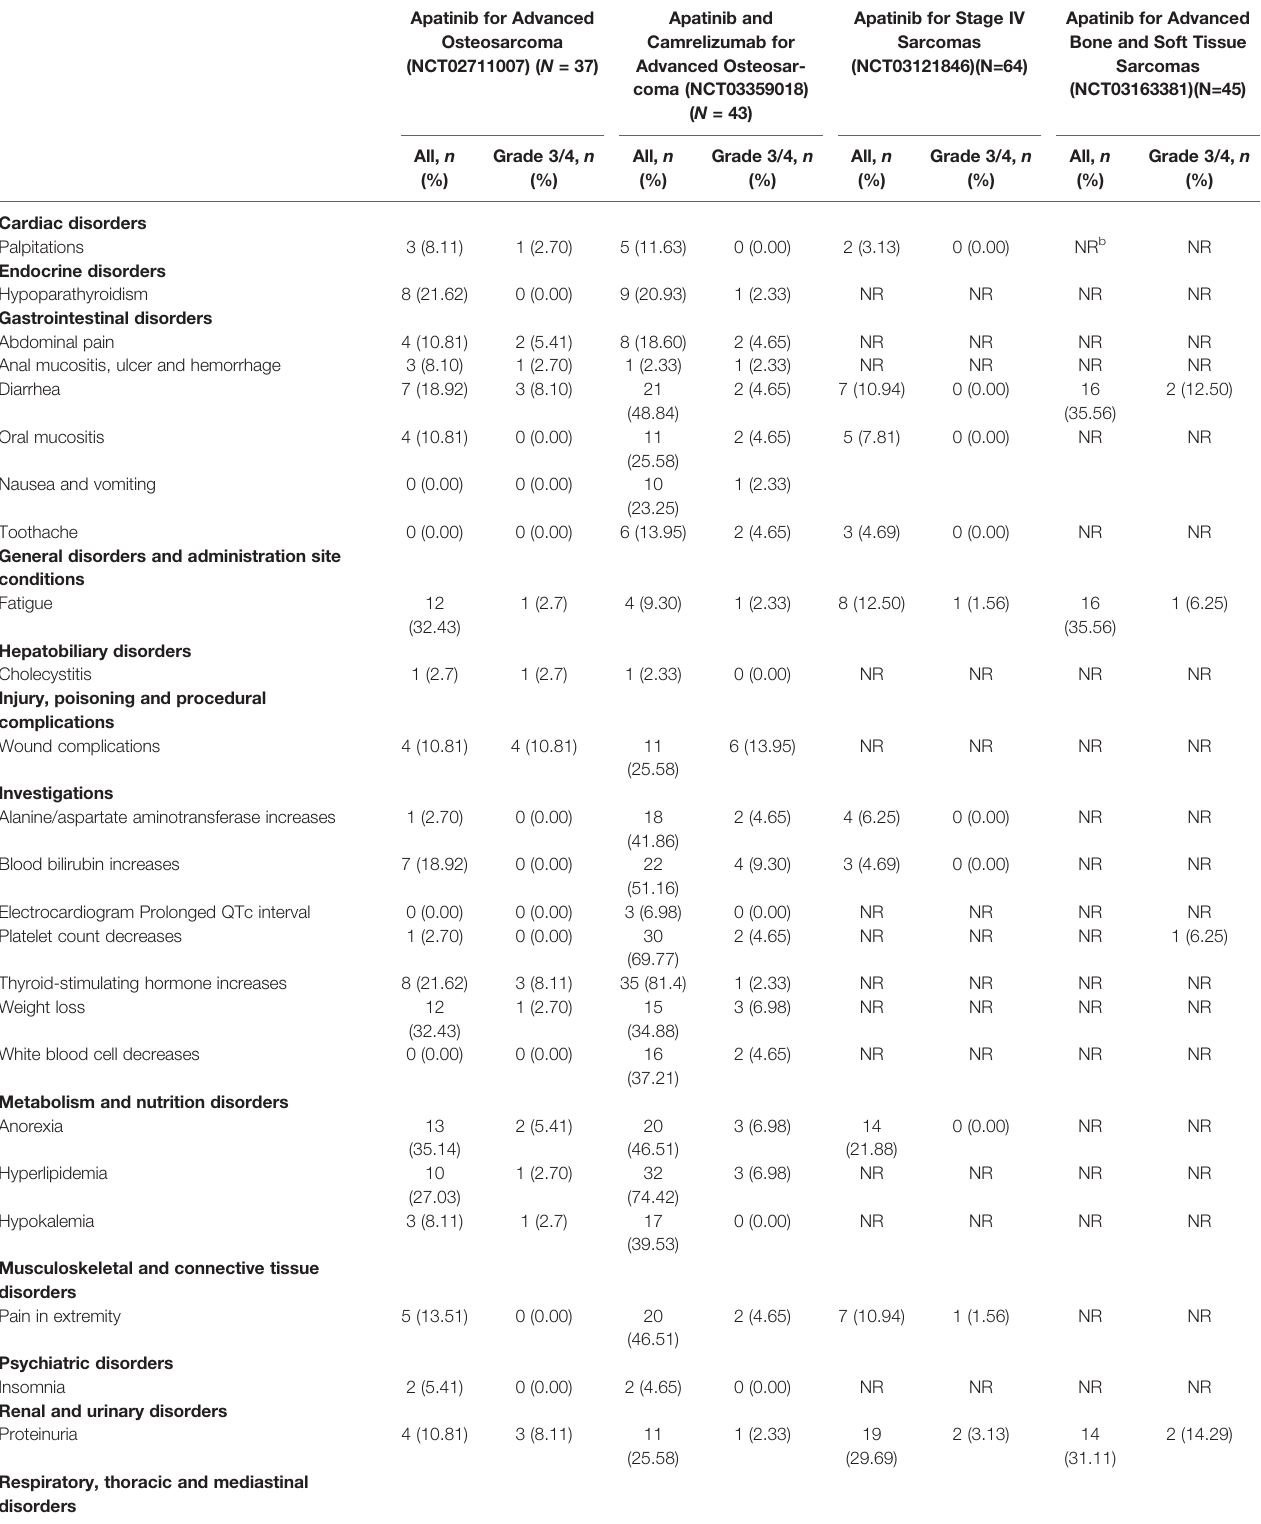
TABLE 1 | Adverse events that arose in the two apatinib-related trials (NCT02711007 and